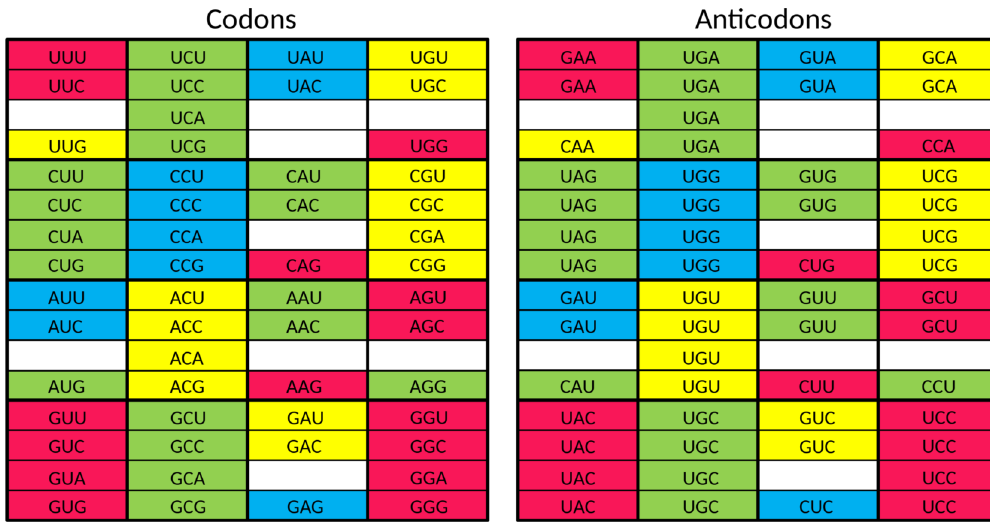
Fig 3. The proposed 23 tRNA stage in the evolution of the standard genetic code. Red, yellow, green, and blue are used to group codons together which are read by a single anticodon.